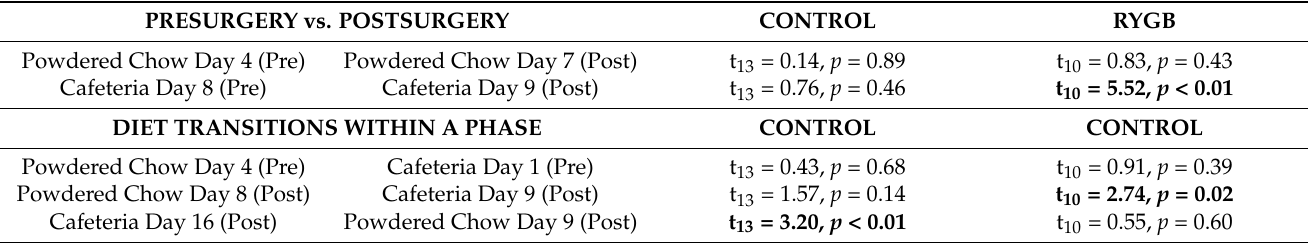
Table 7. Paired t -tests Comparing 22-H Meal Number within Groups across Diets.